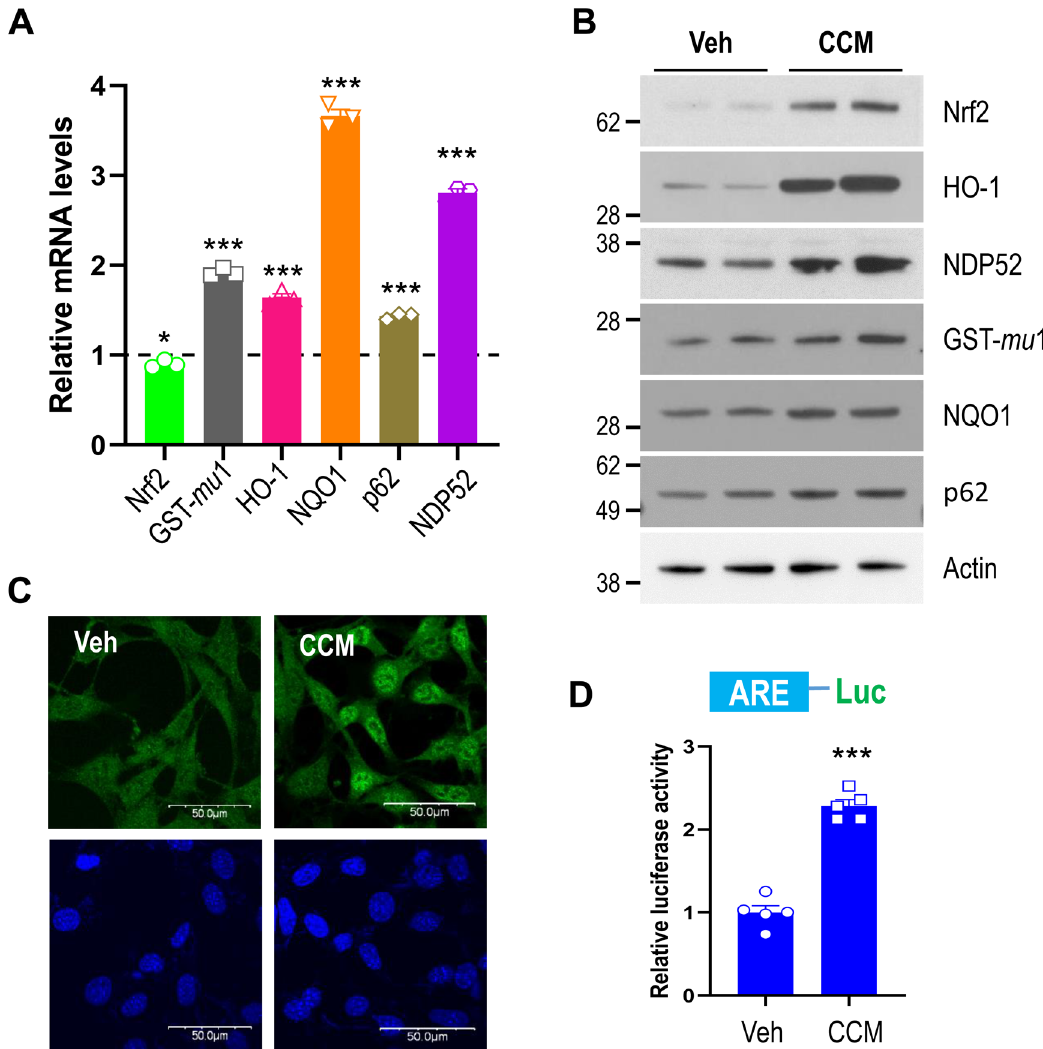
Figure 1. Curcumin activates Nrf2 signaling. ( A ) Mouse cortical cells were treated with either DMSO or 10 μM curcumin for 12 h. The mRNA levels of Nrf2-response genes were analyzed by qRT-PCR as described in the Methods. The bar graph shows the relative mRNA level of genes in the curcumin-treated group compared to the DMSO group. ( B ) The protein levels of Nrf2-response genes in the cells were analyzed by immunoblotting using anti-Nrf2, HO-1, NDP52, GST- mu 1, NQO1, p62, and actin antibodies, respectively. Full blots are provided in Supplementary Fig. S11. ( C ) Mouse cortical cells were treated with either DMSO (Veh) or 10 μM curcumin (CCM) for 6 h. The cells were fixed with 4% paraformaldehyde and immunostained using anti-Nrf2 antibody. Fluorescence signals were observed using a confocal laser scanning microscope. ( D ) Mouse cortical cells were transiently transfected with the ARE-Luc reporter and TK-Renilla plasmids. After treatment with either DMSO (Veh) or 10 μM curcumin (CCM) for 12 h, the cells were assayed for the luciferase activity. Data shown are mean ± S.E. of three independent experiments and were analyzed using the Student’s t -test. ( *p < 0.05, ***p <